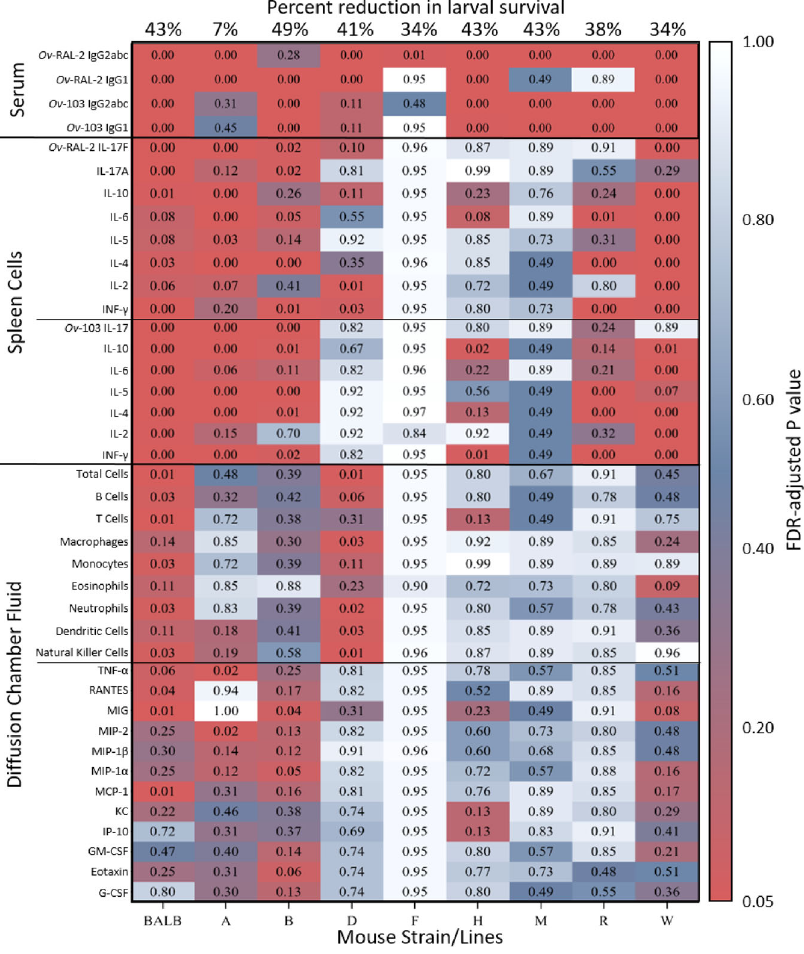
Fig. 2 Heatmap summarizing reduction in parasite recovery, and antibody, cytokine, cell recruitment and chemokine responses. Percent reduction in larval survival comparing vaccinated to control mice is presented on the top row for each strain/line. The data collected from all mice from the present study are summarized using Wilcoxon exact tests. p- values were calculated using Monte Carlo estimation and false discovery rate (FDR)-controlling procedures to compare each measured immunological factor between control and vaccinated mice following challenge. p -Values that approach 1.00 appear in white boxes and progress to blue and then red boxes as they approach a signi fi cant p ≤ 0.05. Serum – measurement in the serum of Ov -RAL-2 and Ov -103 speci fi c IgG1 and IgG2a/b/c; Spleen Cells – measurement of cytokines in supernatant after re-stimulation of spleen cells with Ov- RAL-2 and Ov -103. Diffusion Chamber Fluid – total number and speci fi c cell types as well as measurement of cytokines and chemokines in the parasite